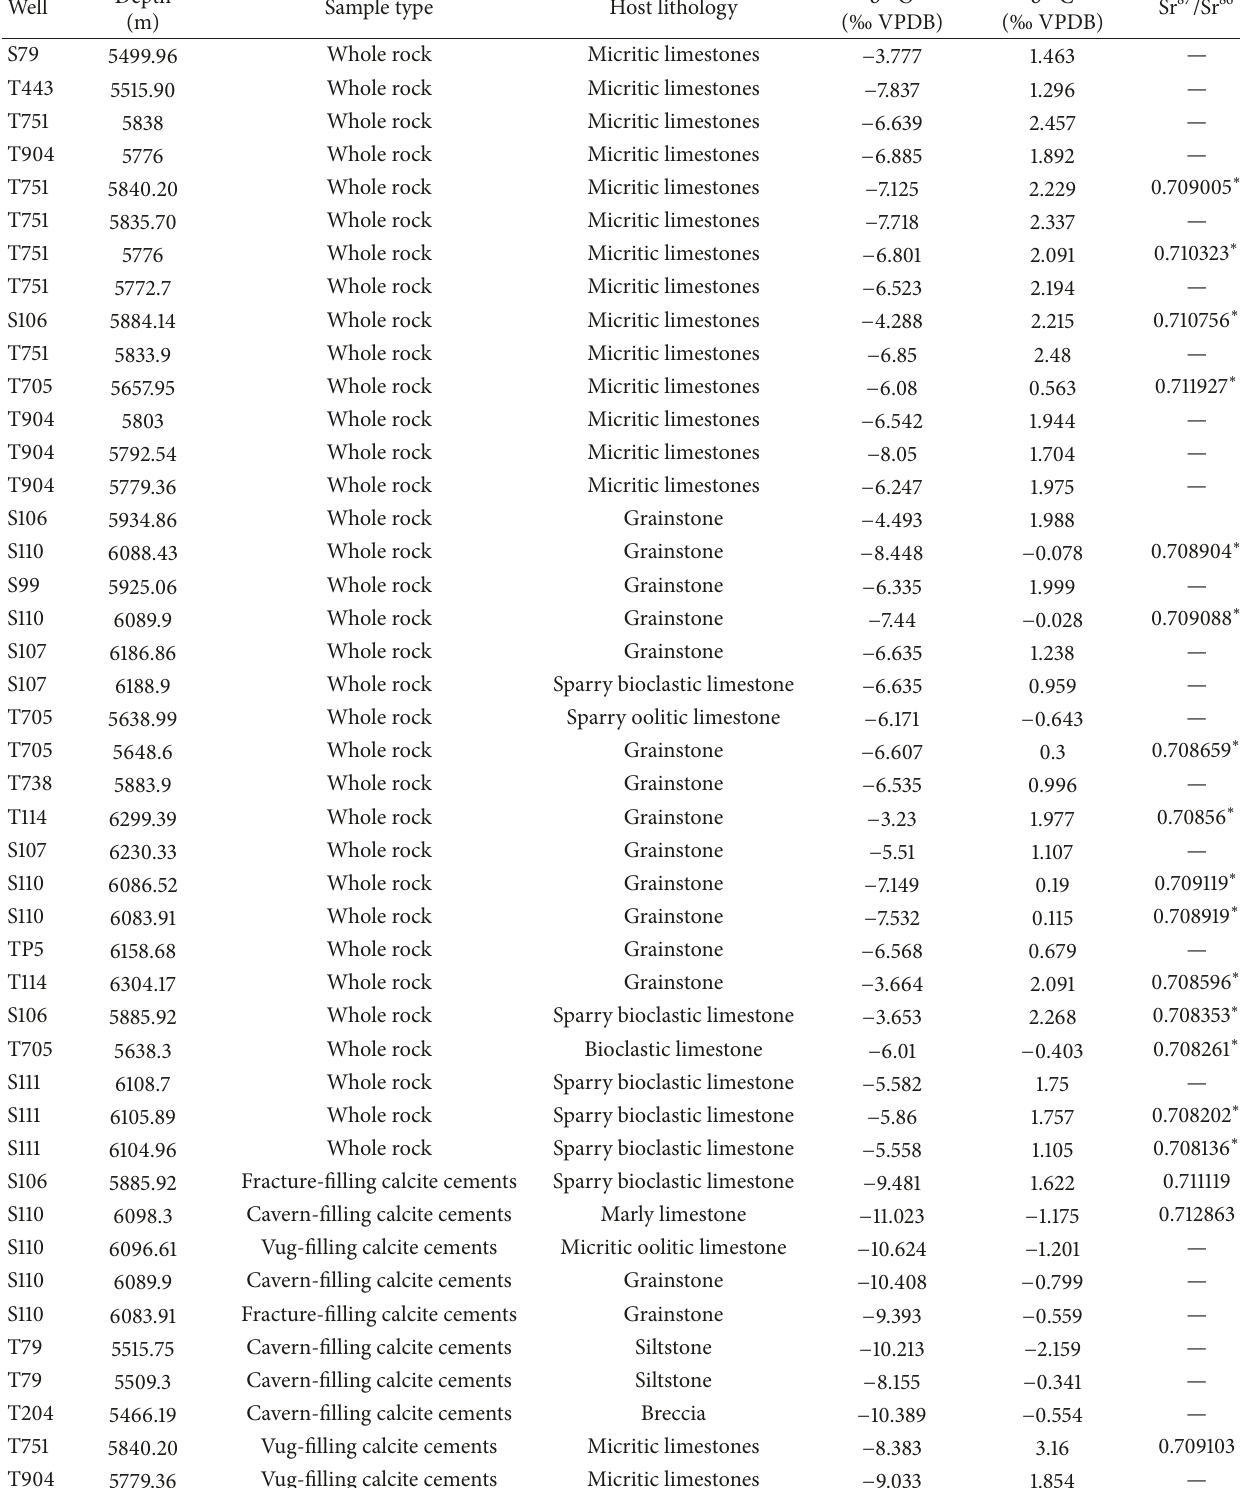
Table 2: Carbon, oxygen, and strontium isotopic data of host rocks and fracture- and vug-filling calcite cements by conventional methods of Lianglitag Formation carbonates in the Tahe